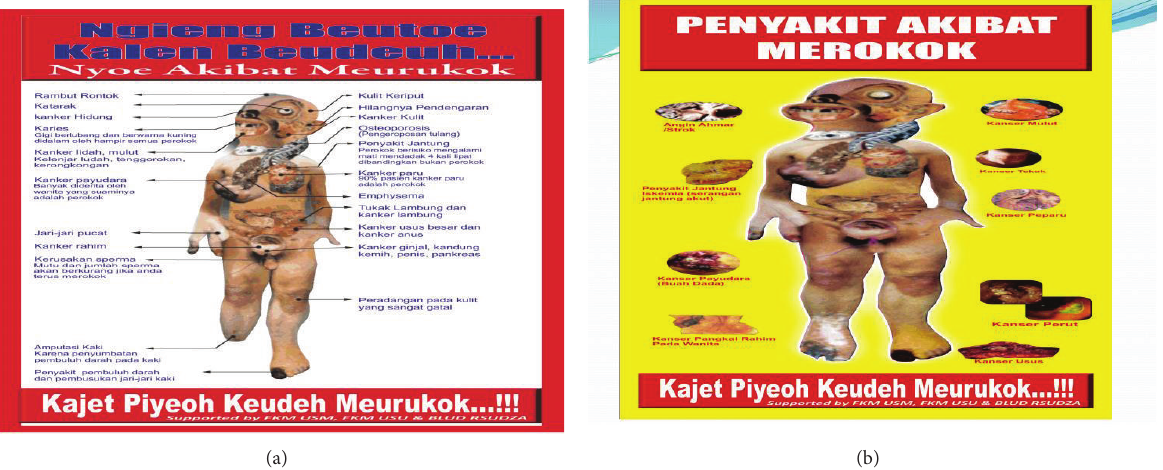
Figure 2: (a) Horror wall poster citing effects of smoking. (b) Another horror wall poster showing effects of smoking Both posters in both Acehnese and Indonesian languages.